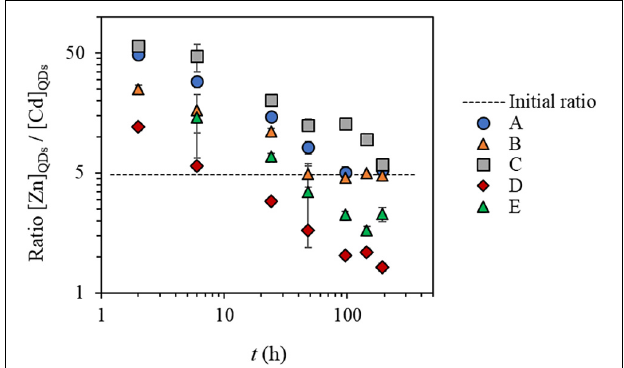
FIGURE 2 | The ratio between Zn QDs and Cd QDs dissolved fraction concentrations compared to the initial Zn QDs and Cd QDs concentration ratio in